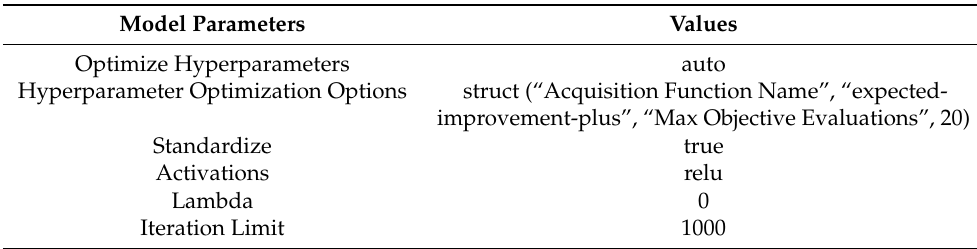
Figure 7. Best-observed and best-estimated objective function value plot against the number of iterations after the last function evaluation. The default values are considered for most of the hyperparameters. However, the significant values considered for training the NNRM are indicated in Table 6. Table 6. The significant values considered for training the NNRM.